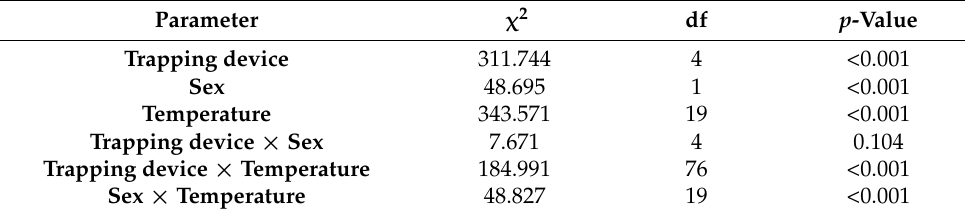
Table 1. Results of the GLMs on the effects of the trapping device, sex, temperature and all two way interactions on adult captures in the field cage trials during both spring and summer season.